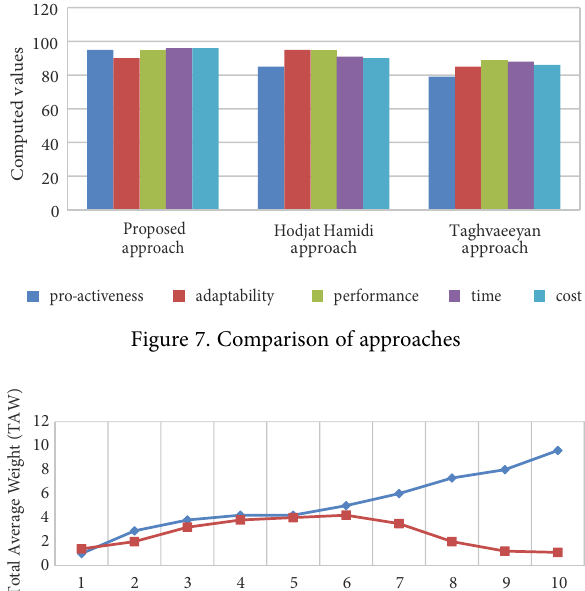
Figure 8. Traffic density before and after